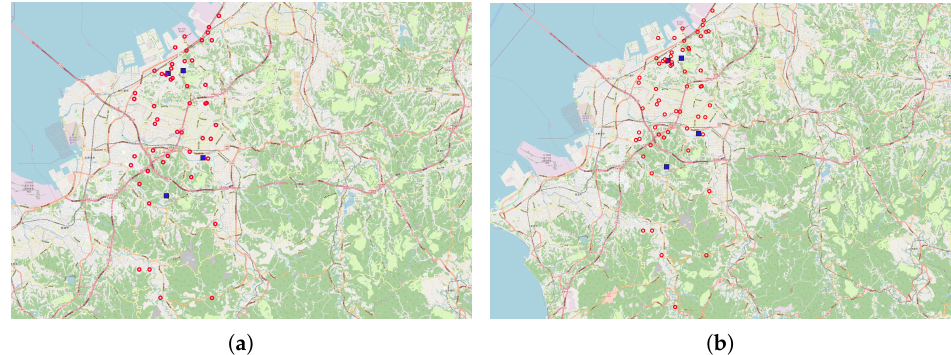
Figure 7. Map of depots and shelters situation. ( a ) The depots and shelters situation of case 1. ( b ) The depots and shelters situation of case 2.